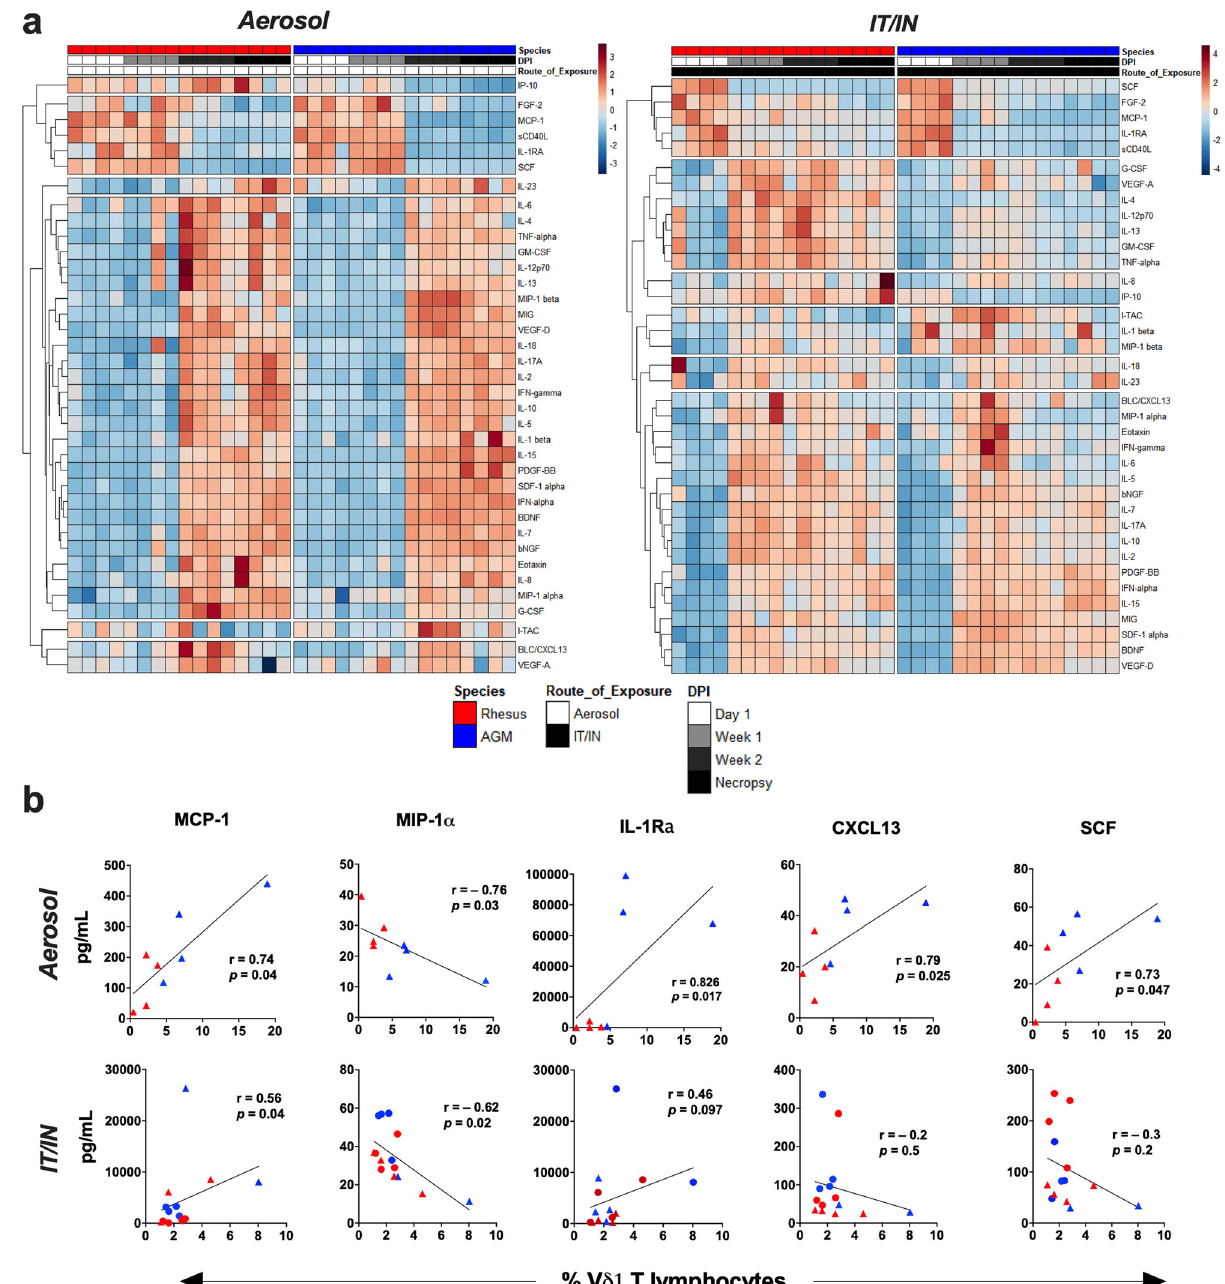
Fig. 8 Cytokine responses in BAL fl uid during SARS-CoV-2 infection and their correlation with local V δ 1 T cell frequencies. a Lower airway cytokine and chemokine expression detected in bronchoalveolar lavage fl uid following aerosol or IN/IT SARS-CoV-2 challenge represented by heatmaps. Each row of the heat map represents a different cytokine/chemokine, each column depicts an individual animal, and groupings of columns are used to organize study timepoints and species. b Spearman Rank correlation between BAL V δ 1 T cell subset frequencies with levels of MCP-1, MIP-1 α , IL-1Ra, CXCL13, and SCF at 14 dpi and 28 dpi in aerosol group ( n = 8/group; upper panel) and IT/IN group ( n = 8 – 16/group; lower panel). Individual values shown for each animal as symbols in orange for RMs and blue for